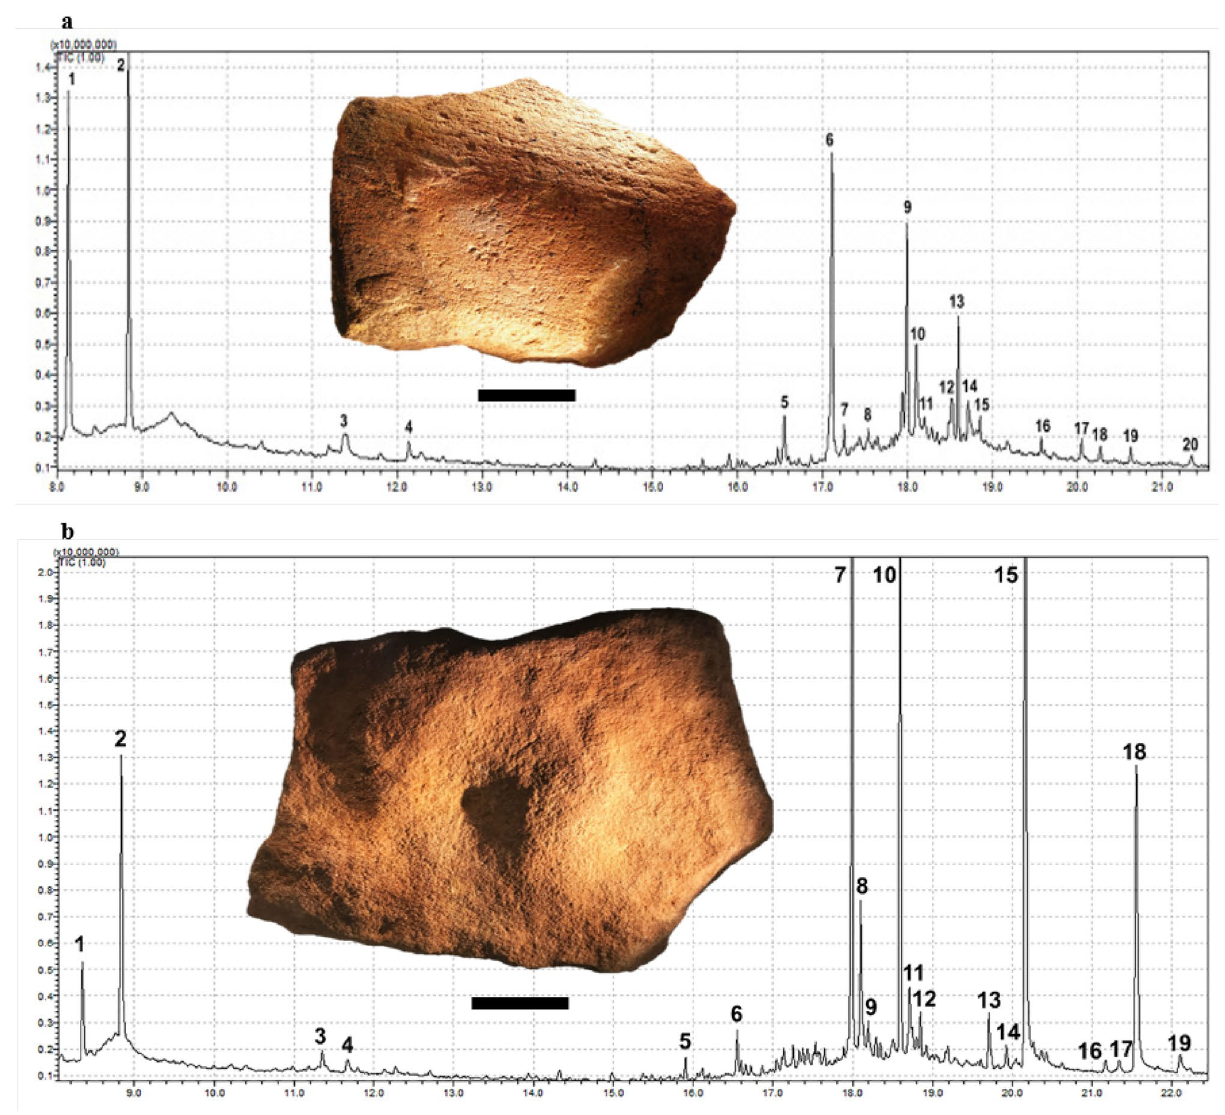
Figure 7. GC–MS chromatographs of seed grinding/pounding tools from Phase 2. ( a ). Detected molecules in extractions sampled from GS73: 1) unidentified carbohydrate; 2) unidentified carbohydrate; 3) degraded amino acid; 4) nonanoic acid; 5) contamination from plastics; 6) methylcyclodecane; 7) dodecanoic acid; 8) pentadecanol; 9) hexadecenoic acid; 10) ascorbic acid; 2,6-dihexadecanoate; 11) 3,7,11-trimethyl-1-dodecanol; 12) pentadecanol; 13) 16-methyl heptadecanoic acid; 14) octadecanoic acid, 2-hydroxy-1,3-propanediyl ester; 15) 8-octadecenal; 16) unidentified terpenoid (similar to farnesan); 17) unidentified terpenoid; 18) contamination from plastics; 19) 10-methyl-nonadecane; 20) 6-methyl-octadecane. ( b ). Detected molecules in extractions sampled from GS75: 1) unidentified carbohydrate; 2) unidentified carbohydrate; 3) 2-methyl-2- phenyl-oxirane (epoxy-Cumene); 4) degraded fatty acid; 5) contamination from plastics; 6) contamination from plastics; 7) hexadecenoic acid (palmitic acid); 8) ascorbic acid, 2,6-dihexadecanoate; 9) unidentified long chain fatty acid; 10) octadecanoic acid; 11) hexadecanoic acid, 1-(hydroxymethyl)-1,2-ethanediyl ester (dipalmitin glycerol); 12) pentadecanol; 13) 2,2’-methylenebis[6-(1,1-dimethylethyl)-4-methyl-phenol (2,2’-methylenebis[6- tert-butyl-)p-cresol); 14) 2,3-dihydroxypropyl hexadecanoate (Monopalmitin); 15) hexadecanoic acid, 2-hydroxy-1-(hydroxymethyl)ethyl ester (2-mono-palmitin); 16) unidentified long chain fatty acid; 17) unidentified long chain fatty acid; 18) octadecanoic acid, 2,3-dihydroxypropyl ester (1-mono-stearin);19) unidentified long chain fatty